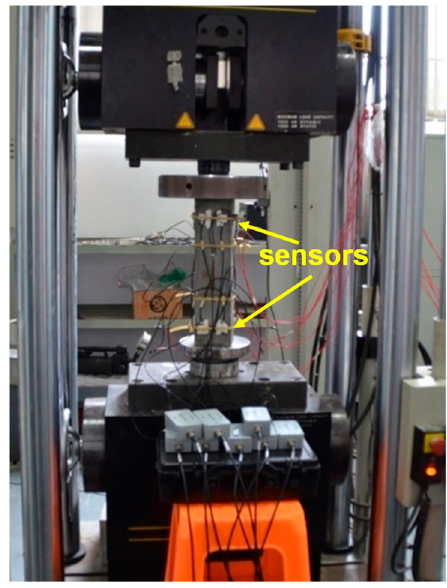
Figure 4. Experimental system.